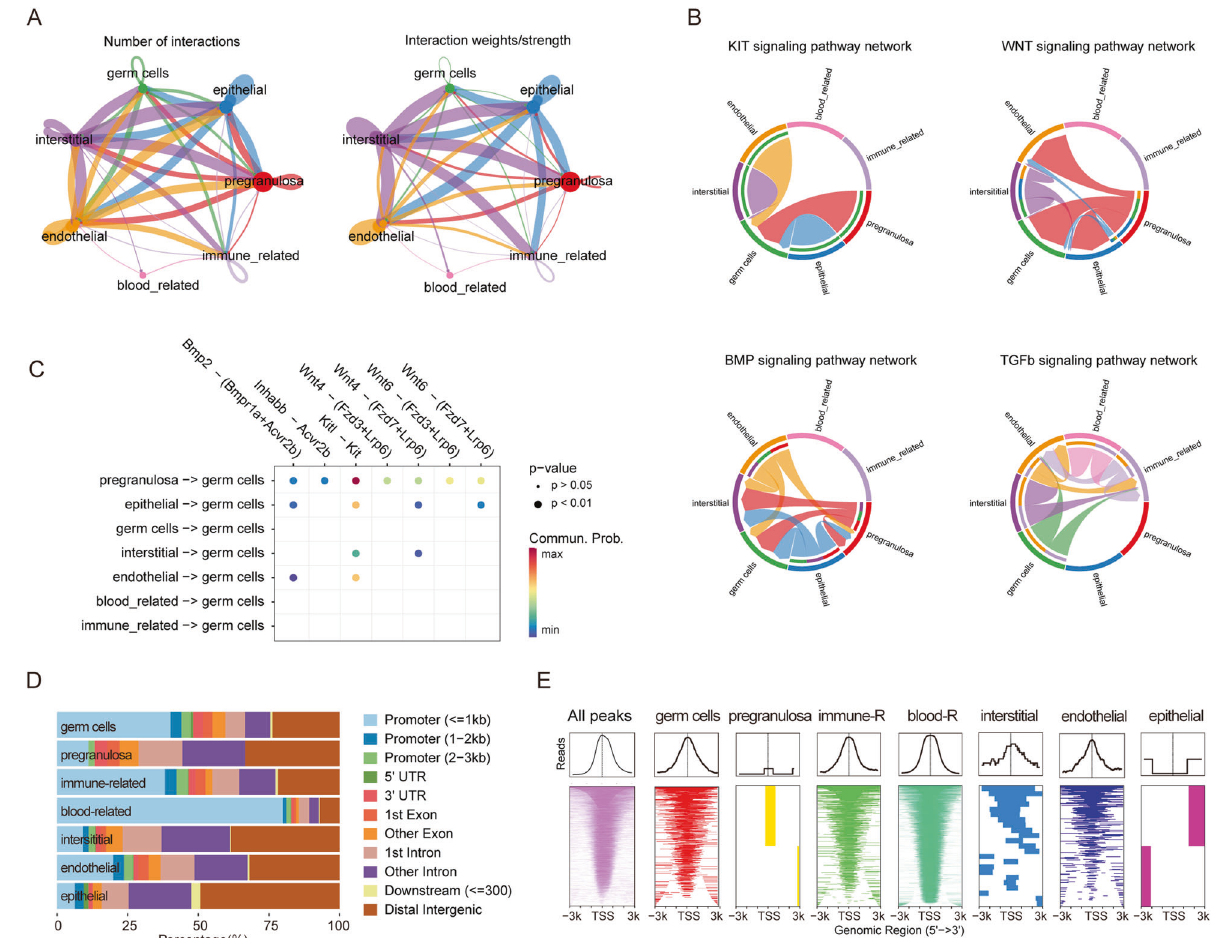
Fig. 2 Transcription and chromatin accessibility characteristics of cells from E11.5 – 13.5 ovaries. A Cellchat of the ligand-receptor pairs across seven cell types during E11.5 - E13.5 embryonic ovary; Left shows the number of ligand-receptor pairs and the right shows the interaction strength. B Four important signaling pathways targeting germ cells, including KIT, WNT, BMP, and TGF β signaling pathways; The width of the line shows the interaction strength. C The heatmap shows important ligand-receptor pairs for targeting germ cells; Red represents strong interactions and blue metabolizes weak interactions. D Location distribution of different cell type-speci fi c peaks. E Relationship between transcription starting site and peaks and different cell type-speci fi c peaks, from left to right are all detected peaks (pink), the speci fi c peaks of germ cells (red), pregranulosa cells (orange), immune-related cells (chartreuse), blood-related cells (light green), interstitial cells (blue), endothelial cells (purple), and epithelial cells (magenta); TSS, transcription starting